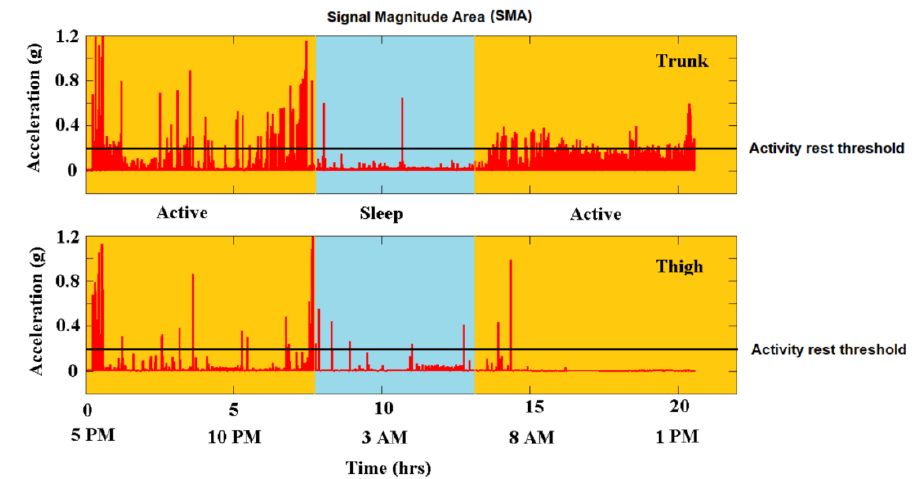
Figure 6. Quantitative accelerometric data acquisition from trunk and thigh sensor . A 53-year-old female patient suffering from left middle cerebral artery infarction and consequential right-sided hemiparesis 1.5 months prior to accelerometric measurement from upper trunk ( top ) and standard position thigh ( bottom ). The patient underwent early neurorehabilitation with a Barthel Index of 20, was wheelchair bound and needed support for position changes. This exemplary quantitative accelerometric analysis shows the advantage of upper trunk accelerometric measurement. The activity rest threshold was set at 0.2 g.